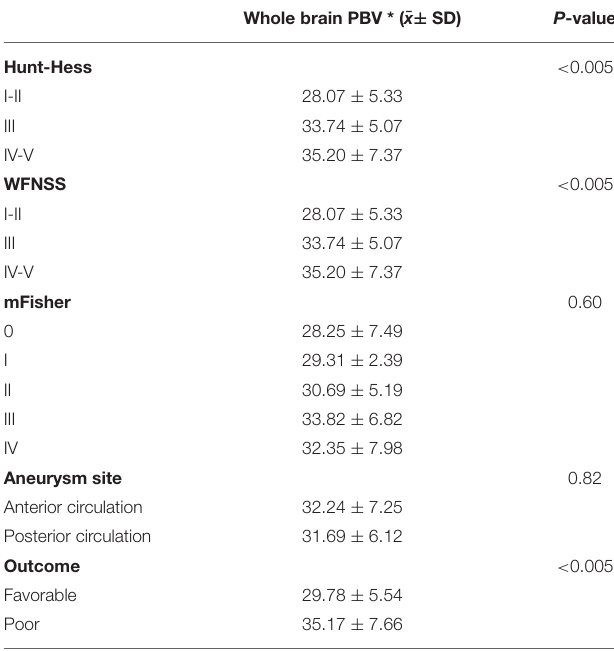
TABLE 3 | Comparison of whole-brain PBV with clinical features and